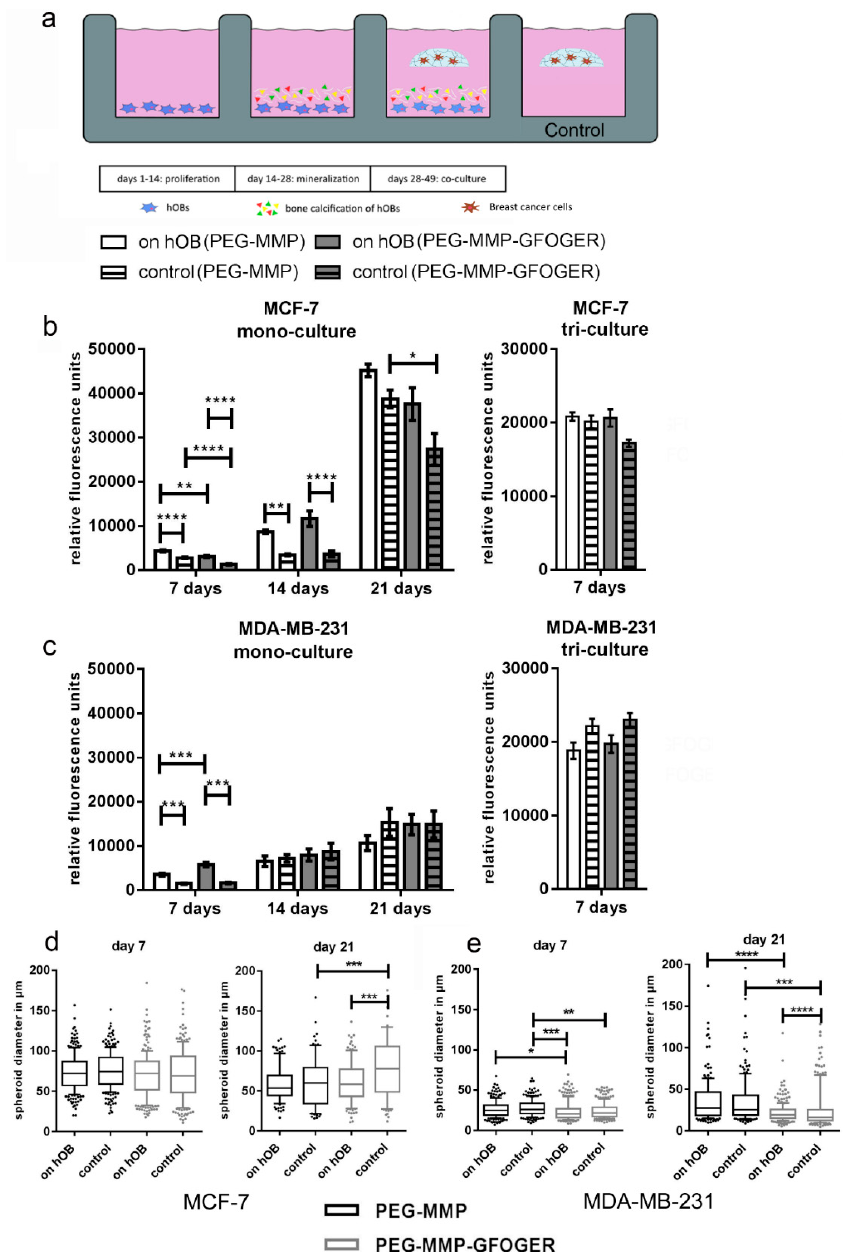
Figure 3. Metabolic activity and tumor spheroid diameter of breast-cancer cells cultured in a 3D–2D